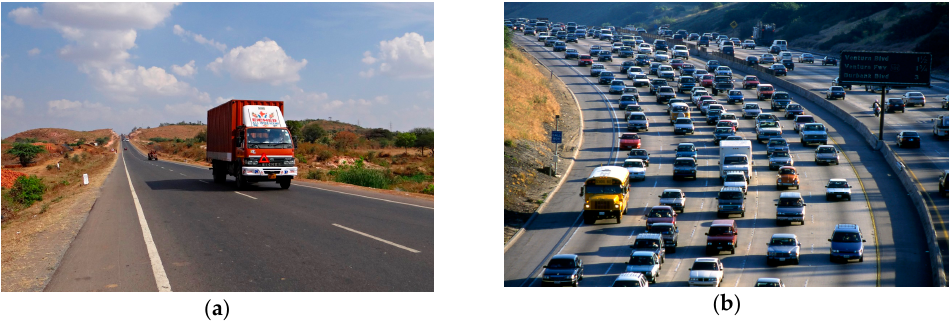
Figure 2. Two different scenarios of V2X system: ( a ) Sparse scenario of V2X; ( b ) Dense scenario of V2X.